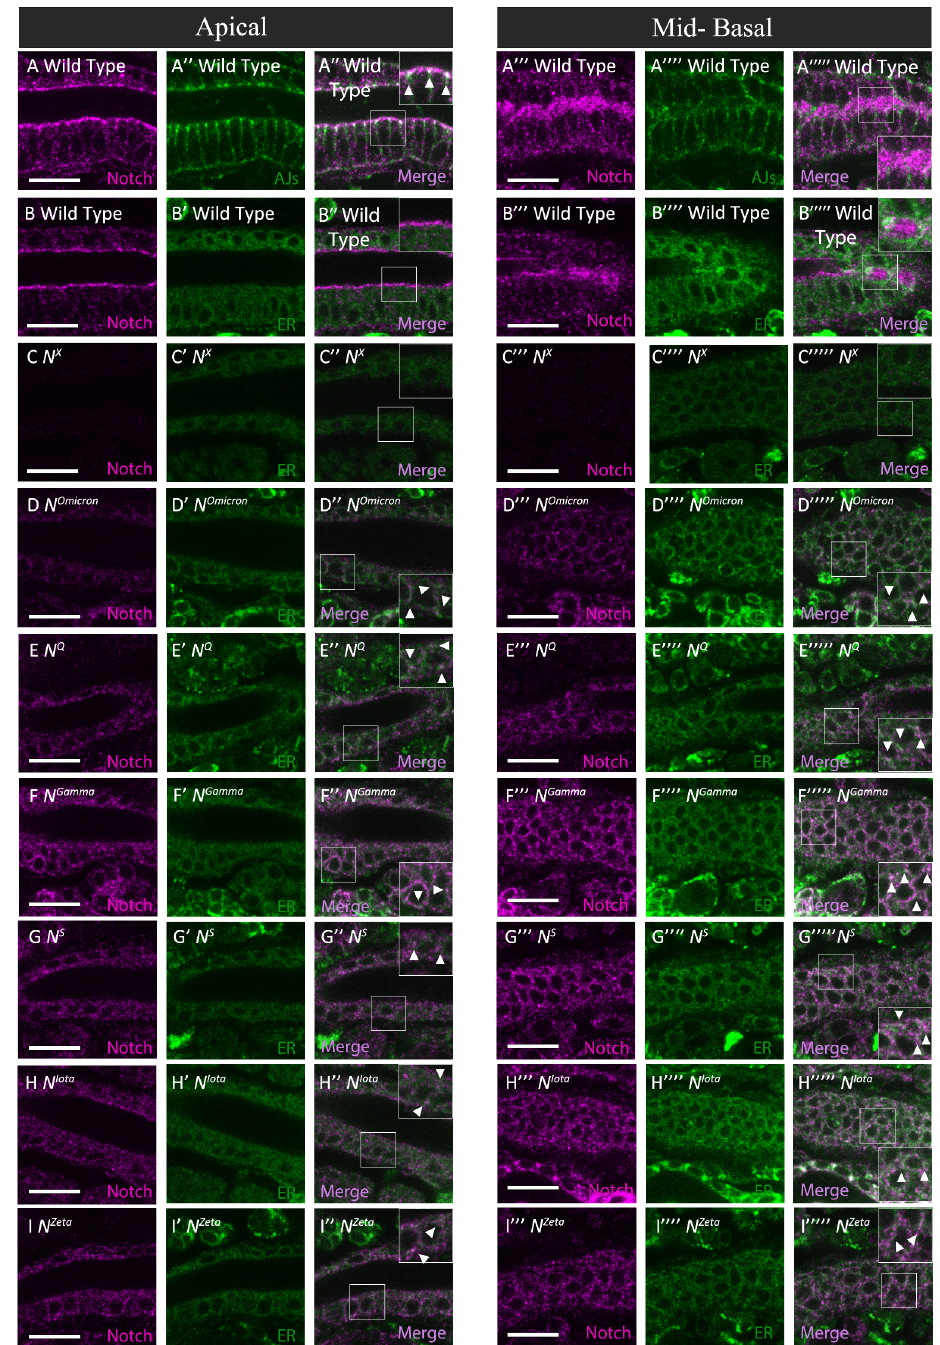
Figure 6. Notch accumulated abnormally in the ER of the hindgut epithelium in Class IV Notch mutants. ( A – I’’’’’ ) Apical and mid-basal images corresponding to the diagrams of apical and mid- basal planes in Figure 5. ( A – B’’’’’ ) Wild-type hindgut epithelium stained for Notch (magenta in A , A’’ , A’’’ , A’’’’’ , B , B’’ , B’’’ , B’’’’’ ), E-Cadherin (green in A’ , A’’ , A’’’’ , A’’’’’ ), and the ER marker Pdi-GFP (green in B’ , B’’ , B’’’’ , B’’’’’ ) using anti-Notch, anti-E-Cadherin, and anti-GFP antibodies. ( C – I’’’’’ ) Notch (magenta, left panels) and Pdi-GFP (green, middle panels) were observed by anti-Notch and anti-GFP antibody staining, respectively, in the hindgut epithelium of ( C – C’’’’’ ) N X , ( D – D’’’’’ ) N Omi- cron , ( E – E’’’’’ ) N Q , ( F – F’’’’’ ) N Gamma , ( G – G’’’’’ ) N S , ( H – H’’’’’ ) N iota , and ( I – I’’’’’ ) N Zeta hemizygotes. Right- side panels in apical and mid-basal images, indicated by ’’ and ’’’’’, respectively, are merged from the left and middle images. Insets in the right panels indicated by ’’ and ’’’’’ are highly magnified views of regions in white rectangles. Intracellular punctae where Notch and Pdi-GFP colocalized are shown by white arrowheads. All results were confirmed by staining biological triplicates. Scale bars: 10 μ m.